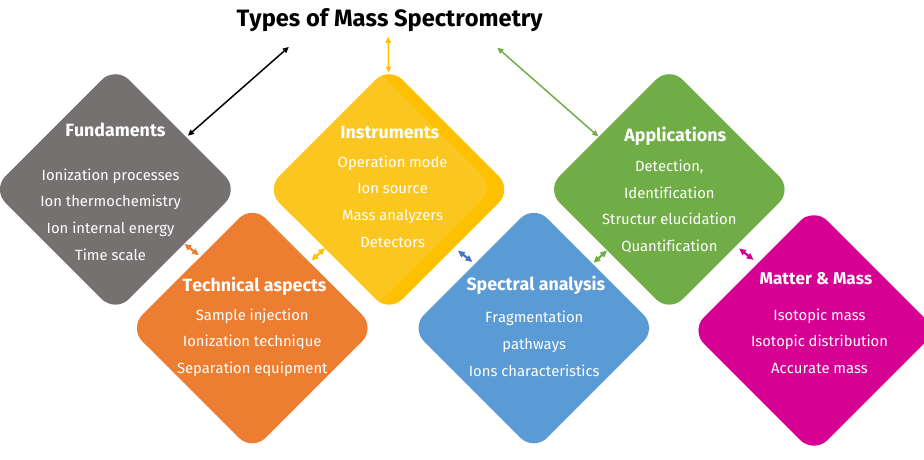
Figure 3. Recent technical innovations in MS-based techniques.